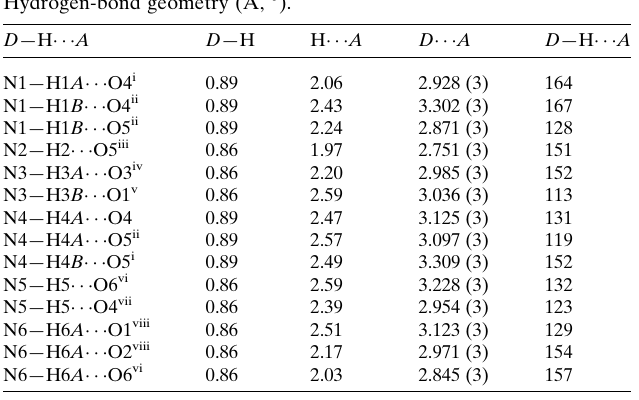
Table 2 Hydrogen-bond geometry (A˚ , (cid:4)